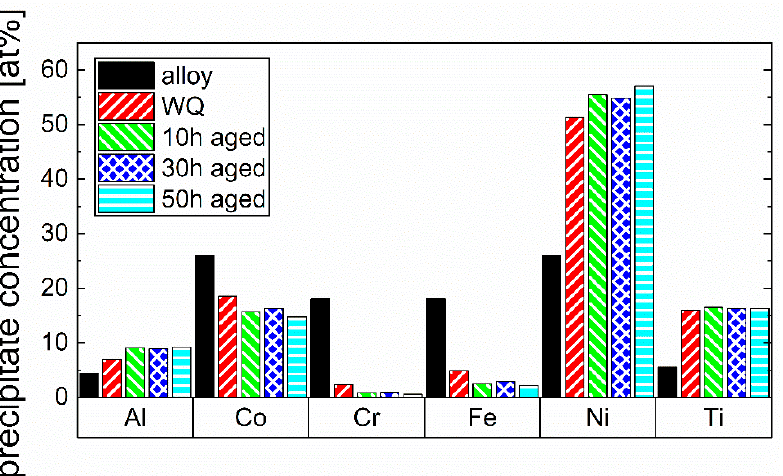
Figure 5. Comparison of the nominal alloy composition (alloy) with the chemical compositions of the precipitate phase in the WQ and the three aged states (all after homogenization and annealing) of the CCA. An accumulation of Al, Ti, and Ni and a depletion of Co, Cr, and Fe can be seen in the precipitate phase with aging.